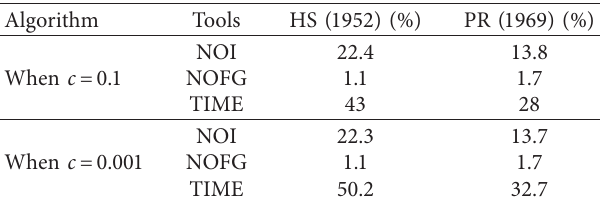
Table 4: Standardizing perceptual of the new algorithm vs. HS and PR